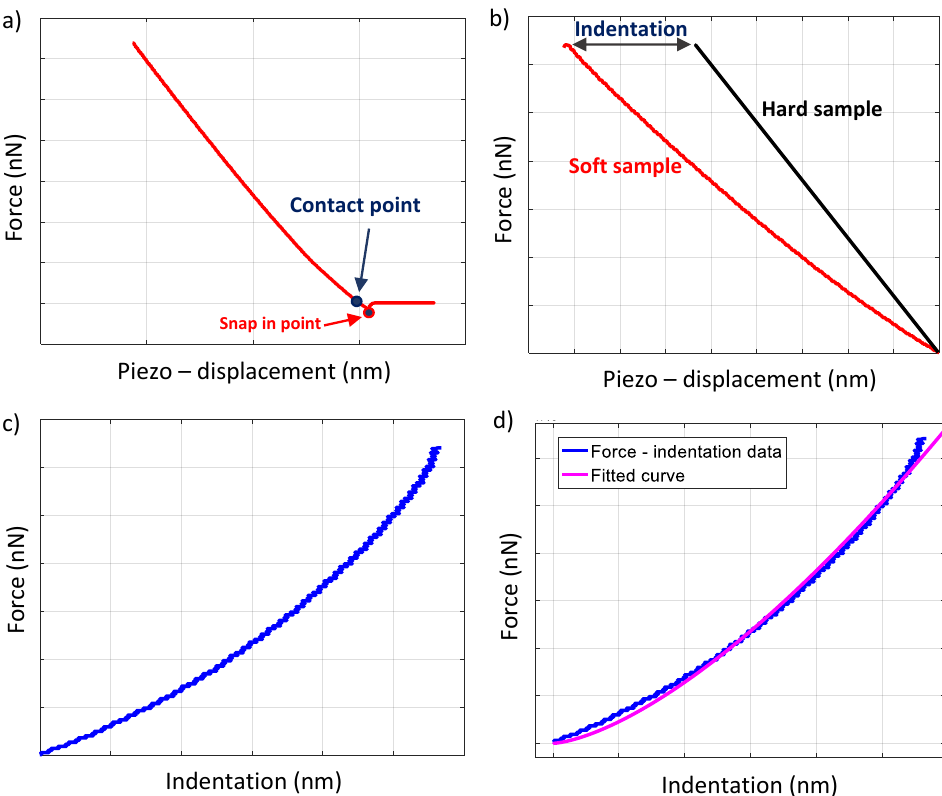
Figure 3. Data processing. ( a ) A force–piezo-displacement curve is obtained on the sample of interest and the contact point is determined. ( b ) The force-piezo-displacement curves for the sample of interest (soft sample) and for a reference material that is not being deformed by the tip (hard sample). ( c ) The piezo-displacements between the soft and the hard sample are subtracted and a force–indentation curve is created. ( d ) An appropriate model from contact mechanics is fitted to the experimental force – indentation curve.